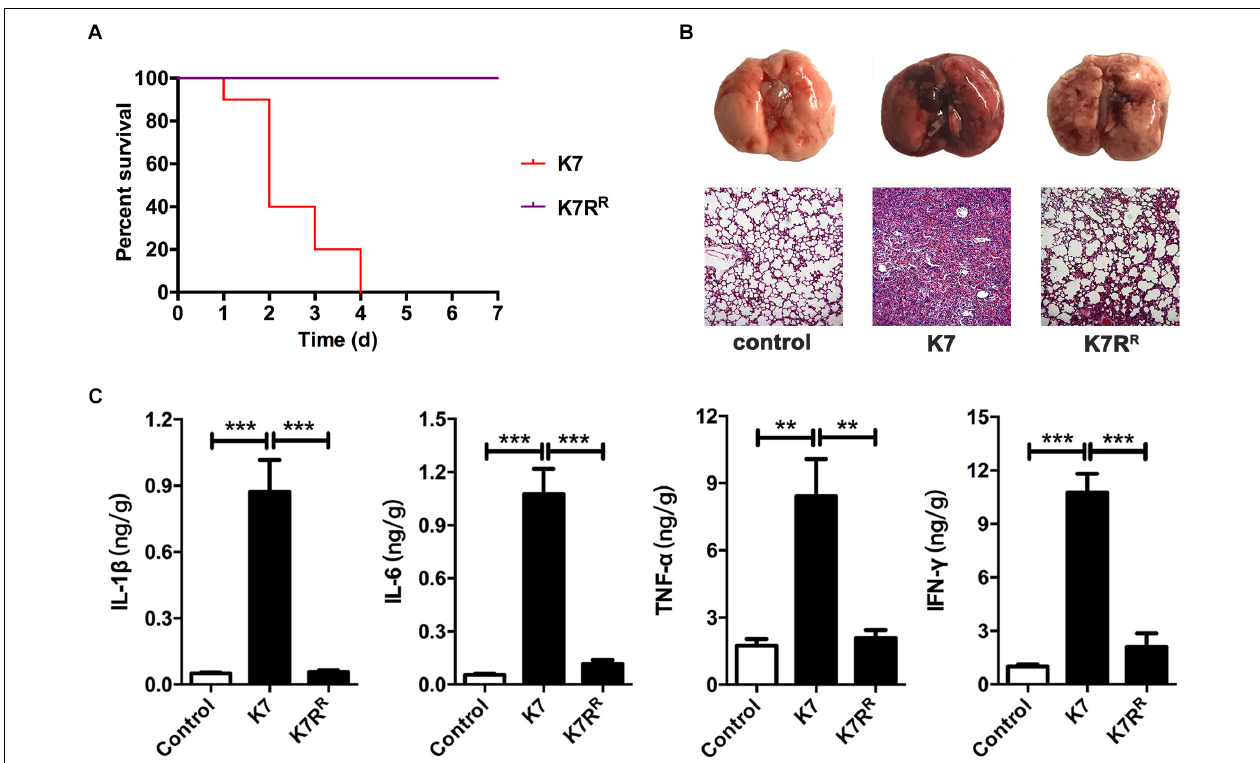
FIGURE 2 | Virulence evaluation of K. pneumoniae K7 and K7R R in vivo . All the mice were challenged intranasally with 1 × 10 7 CFU/mouse of K. pneumoniae K7 and K7R R . (A) Survival rates of mice challenged with K. pneumoniae K7 and K7R R . Each group contained ten mice. Statistical analysis was performed using the Kaplan–Meier method [ P < 0.0001, log-rank (Mantel–Cox) test]. (B) Pathological observation. At 48 h after infection, the lungs from mice challenged with K. pneumoniae K7 and K7R R were carefully removed and photographed after euthanasia. Lung tissue sections were stained with hematoxylin and eosin (H&E) and then observed in a microscope at a magnification 100 × . Lung tissues of healthy mice were served as controls. (C) The levels of cytokines. The levels of IL-1 β , IL-6, TNF- α , and IFN- γ in lung tissue homogenates of mice infected by K. pneumoniae K7 and K7R R were determined. Lung tissue homogenates of healthy mice were served as controls. ∗∗ and ∗∗∗ represent significant differences at P < 0.01 and P < 0.001, respectively. Data represent the mean ± SEM of triplicate